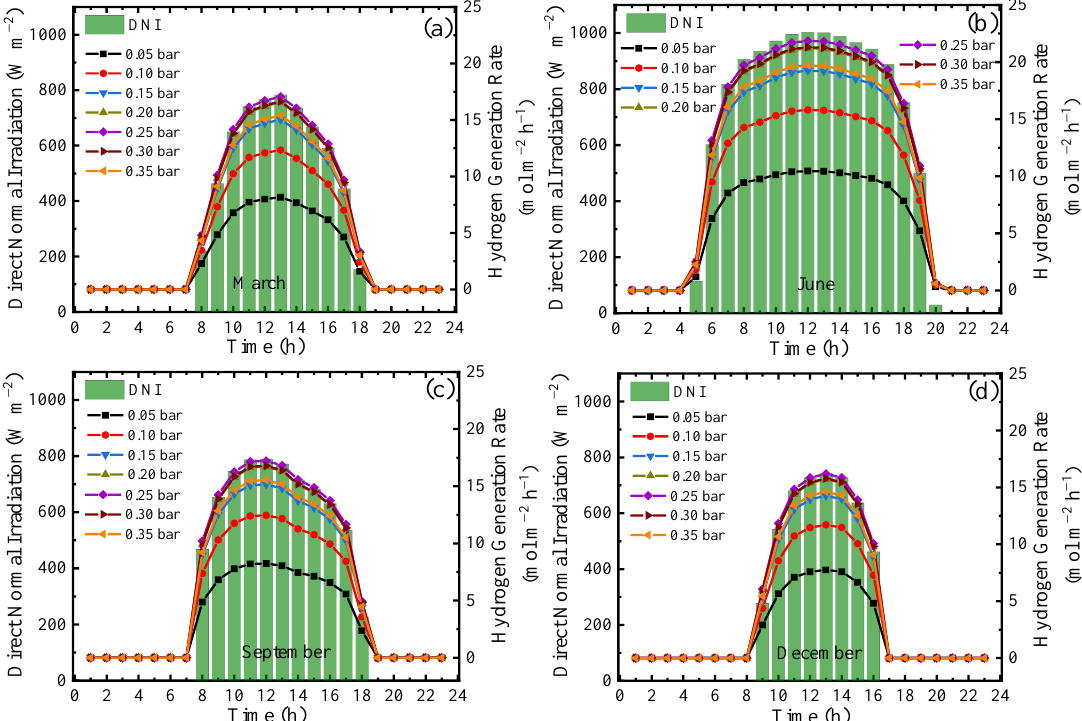
Figure 12. Variation in DNI and Y H2 on a typical sunny day of different months for different permeate pressures at a reaction temperature of 150 °C with real separation energy ( η s → e = 15%): ( a ) March; ( b ) June; ( c ) September; and ( d ) December.